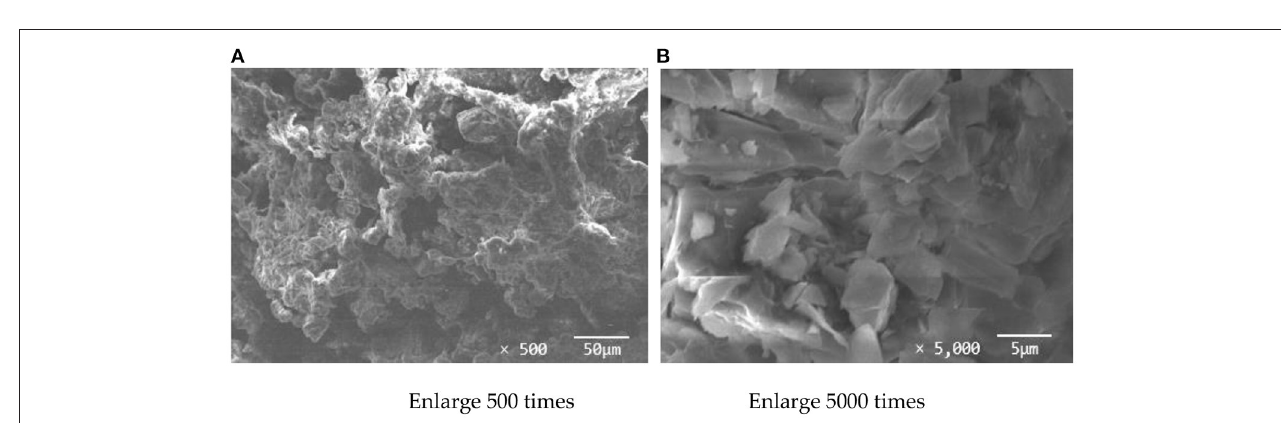
FIGURE 23 | SEM images of polyether-based TPU-modified asphalt. (A) Enlarge 500 times. (B) Enlarge 5000 times.